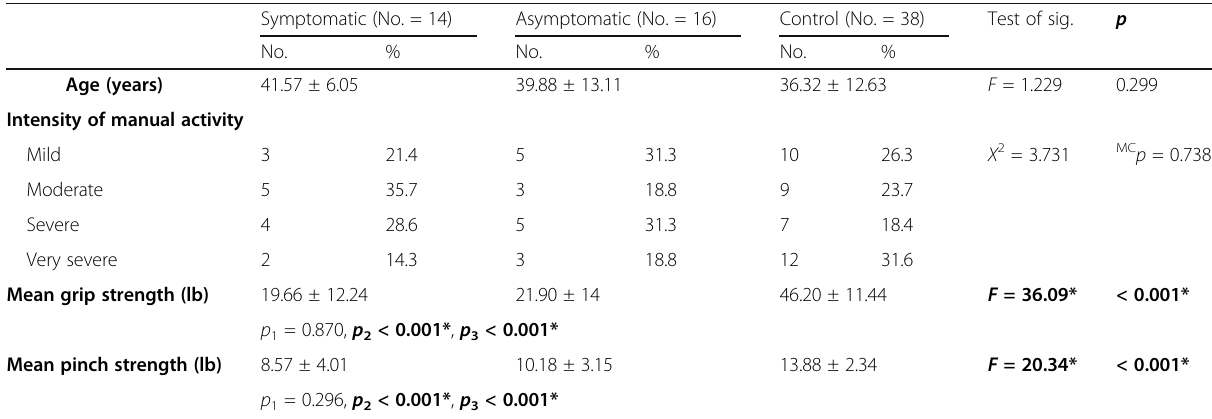
Table 1 Distribution of the studied groups according to age, manual labour and grip and pinch dynamometry Symptomatic (No. = 14) Asymptomatic (No. = 16) Control (No. =